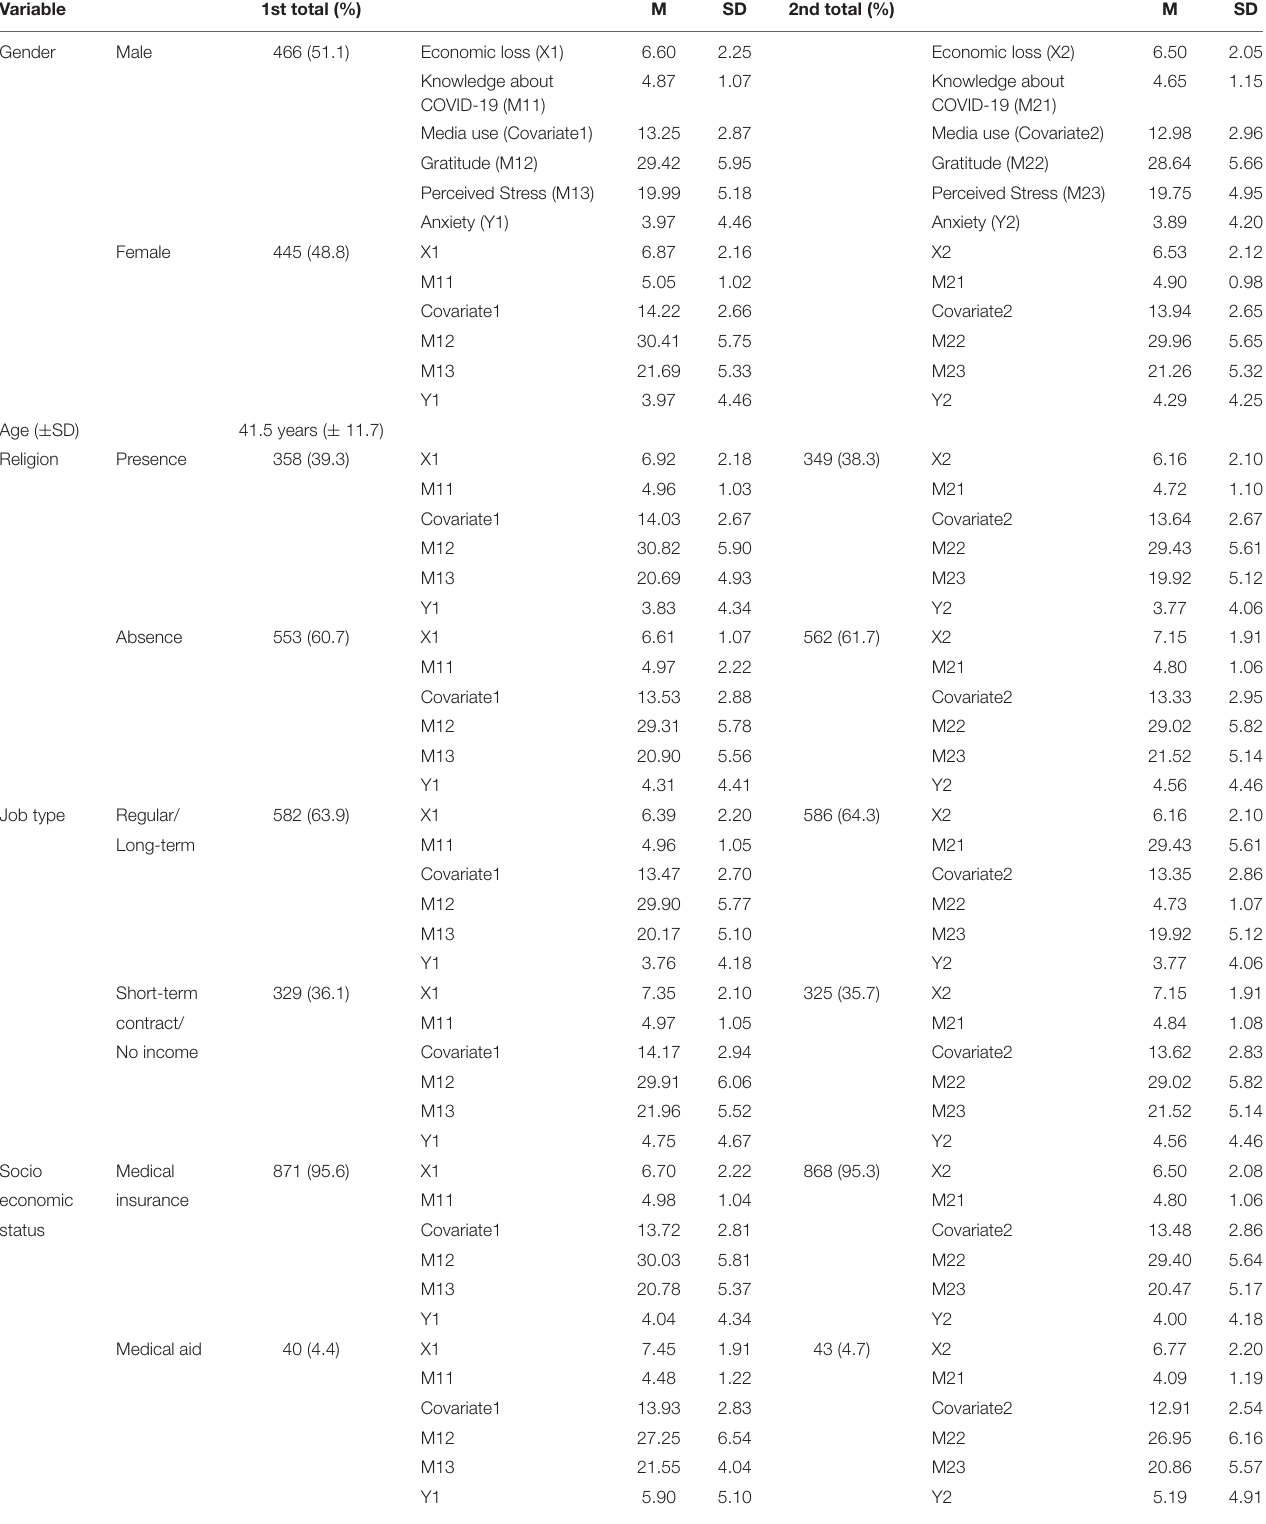
TABLE 2 | Frequencies, means, and standard deviations of key variables by sociodemographic group (N = 911).